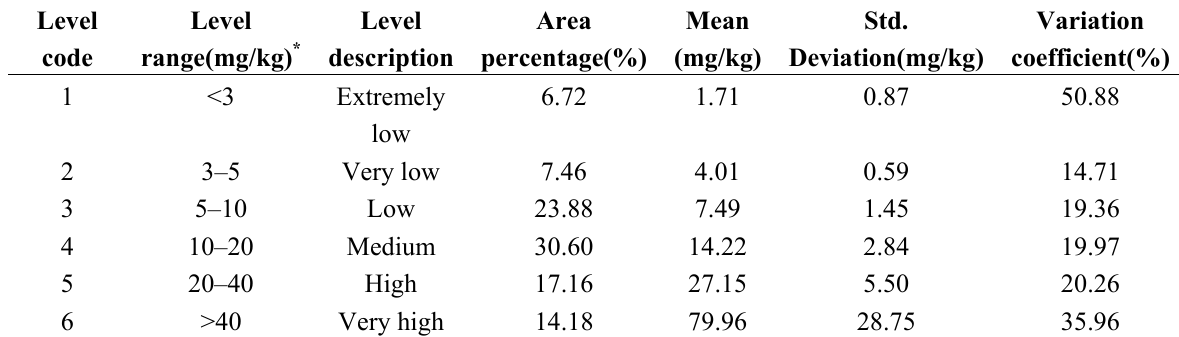
Table 5. Summary statistics of soil available phosphorus of different nutrient